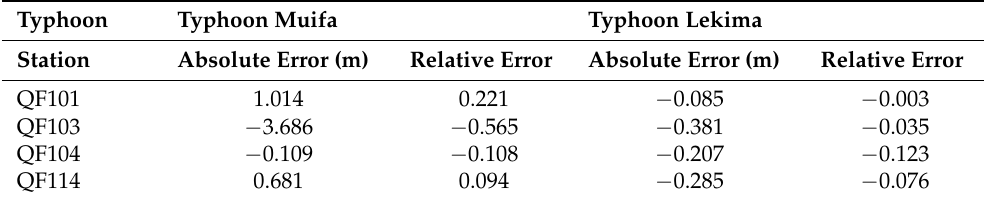
Table 4. The absolute error and relative error between the observed data and ERA5 reanalyzed data for the wind speed at four stations (QF101, QF103, QF104, and QF114) during Typhoon Muifa and Typhoon Lekima. Significant digits are reserved to three decimal places. Typhoon Typhoon Muifa